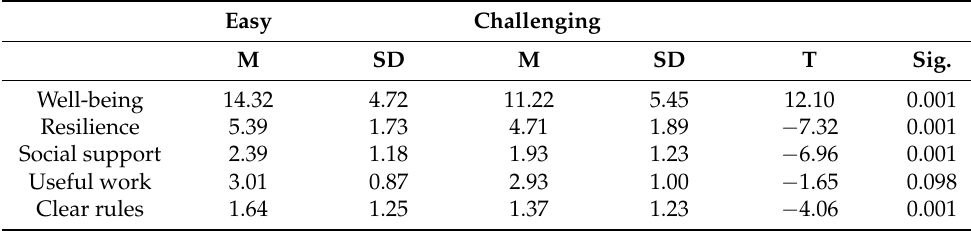
Table 2. Independent samples t -tests. Samples descriptive using t -tests ( N = 1665).